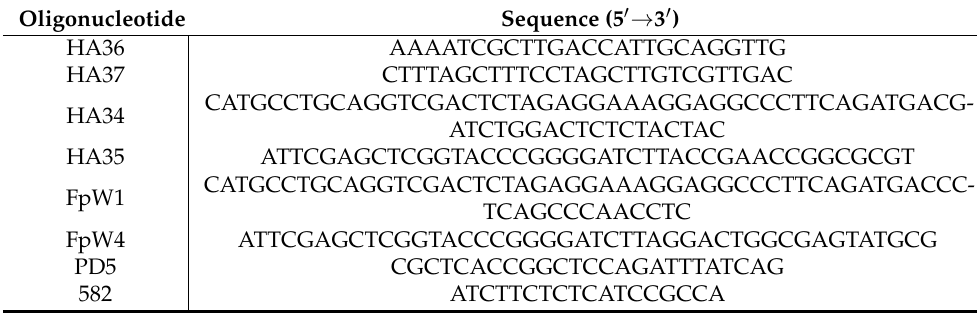
Table 2. Oligonucleotides used in this